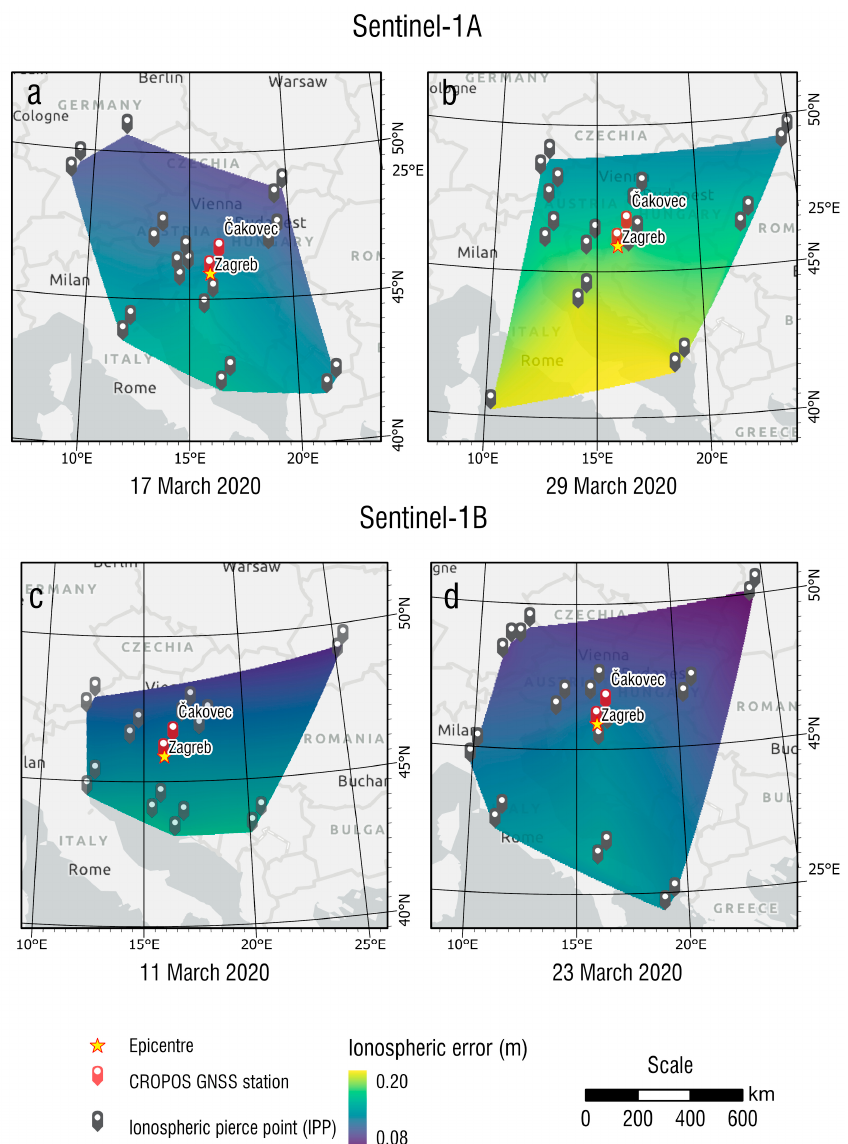
Figure 6. Vertical single ionospheric crossings interpolated between IPPs at the time of taking Sentinel-1A images for a DInSAR pair ( a , b ) and Sentinel-1B images for a DInSAR pair ( c , d ).